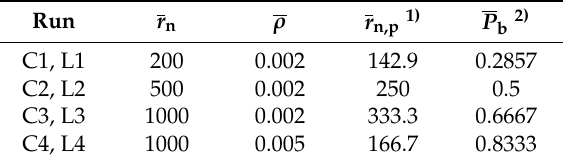
Table 3. Properties set to be the same for the corresponding conventional and living FRP.